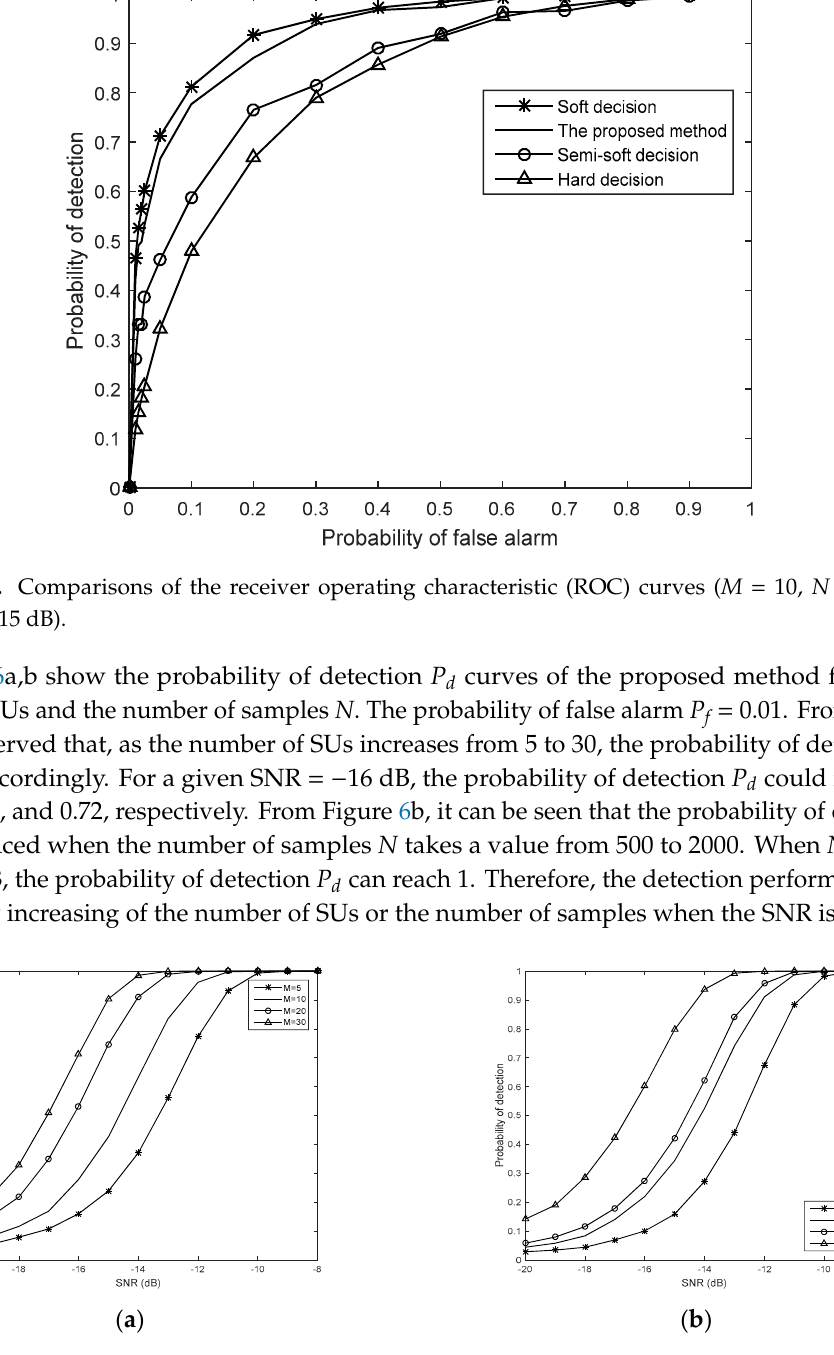
Figure 6. The probability of detection P d curves of the proposed method: ( a ) Different number of secondary users (SUs) ( M = 5, 10, 20, 30, N = 1000); ( b ) Different numbers of samples ( N = 500, 800, 1000, 2000, M = 10).